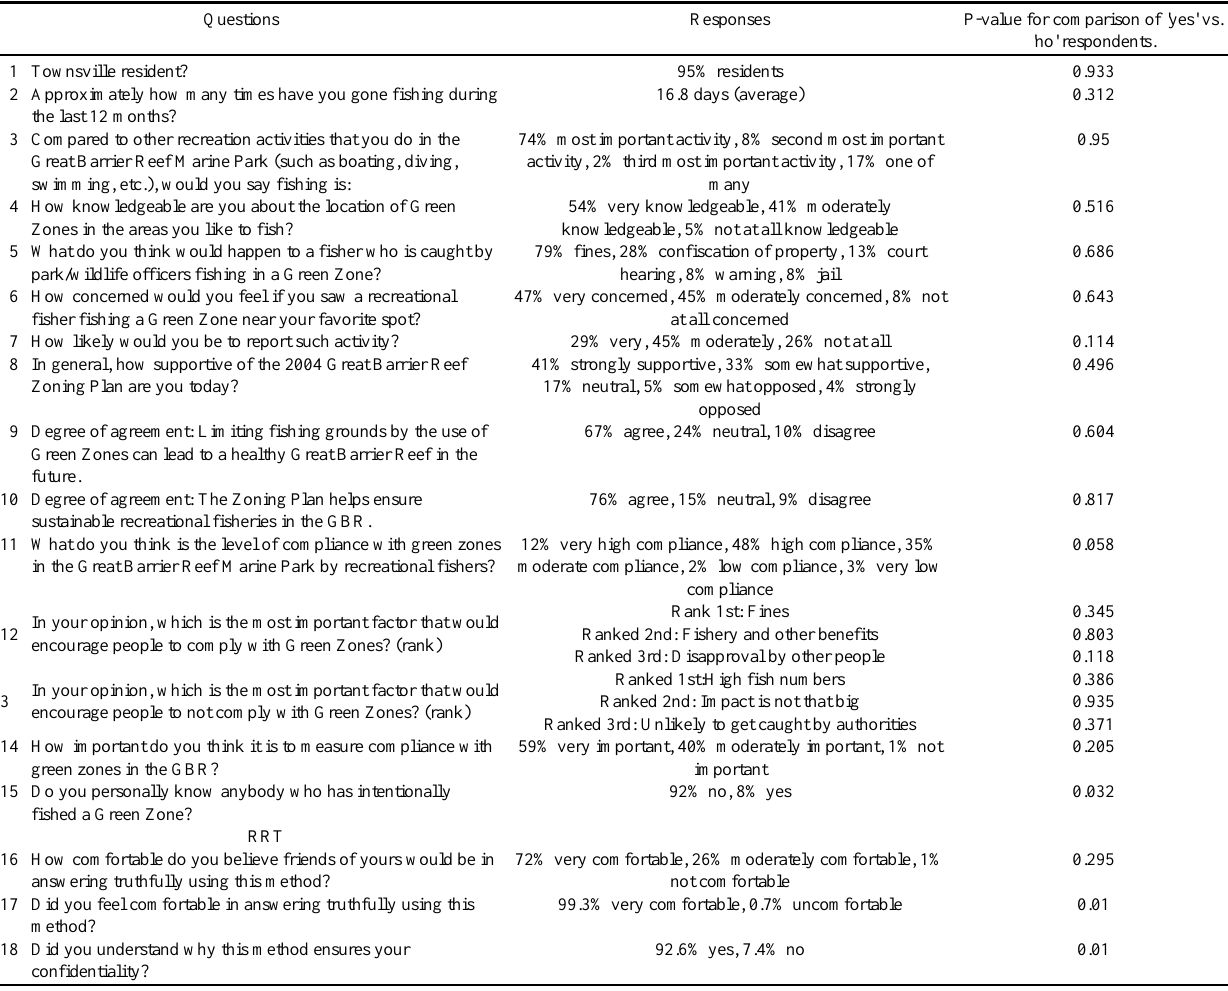
Table 1 . Questionnaire items, responses and comparison between 'yes' vs. 'no' respondents to the RRT question.